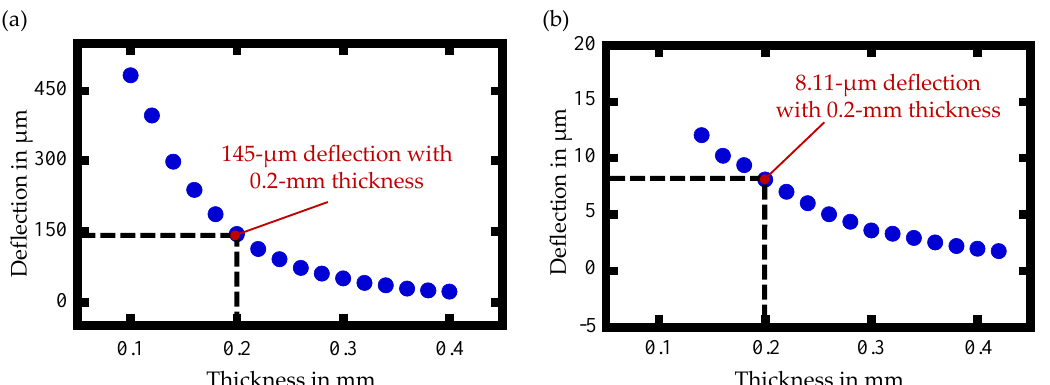
Figure 4. The simulation results obtained by FEM: ( a ) V-beam; ( b ) X-beam.